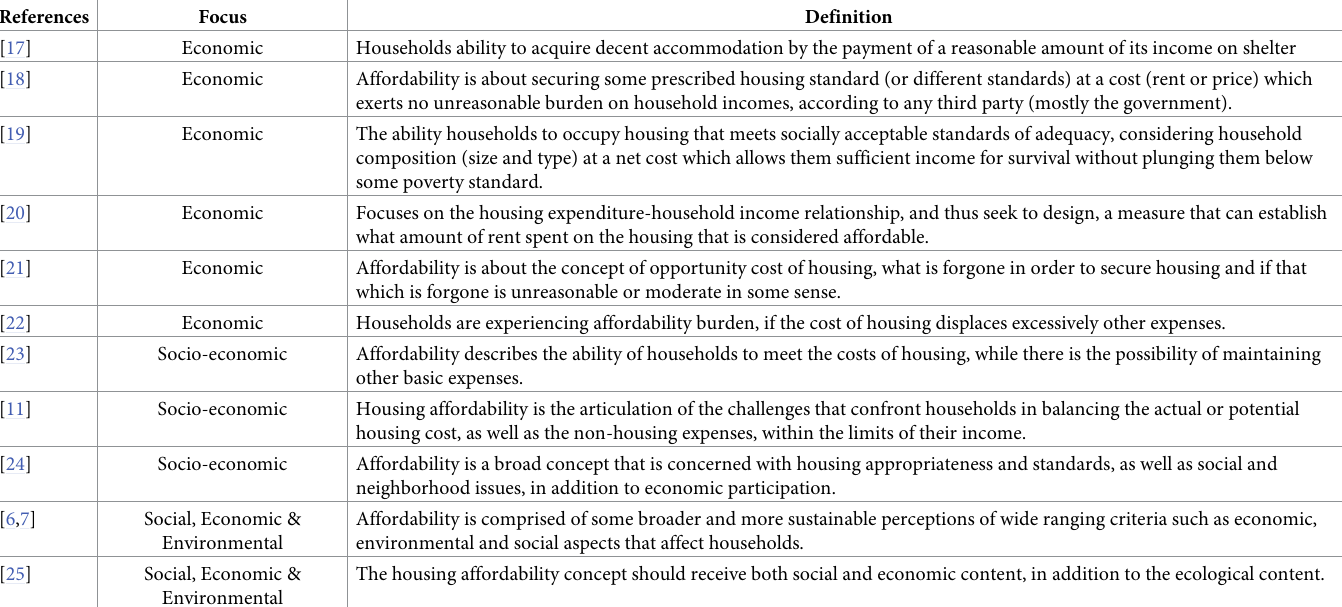
Table 1. Selected key definitions of housing affordability based on